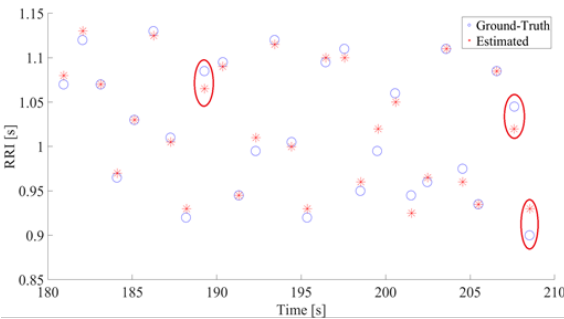
Figure 6. The Estimated RR and Truth RR (a sample of 30-s data). The Y and X axis show the RRI and time, respectively. In both figures, estimated RR is represented with asterisks and ground truth with circles. The instances where ground-truth and estimated RR differs by at least 0.02 s are circled in